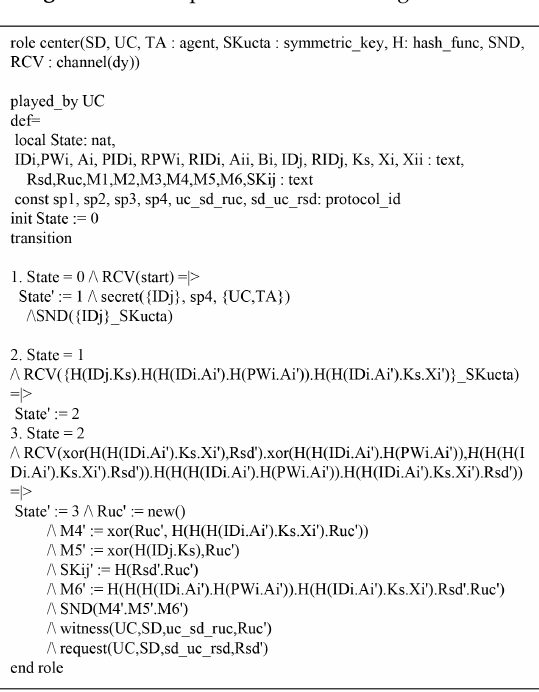
Figure 10. Role specification of smart grid device.